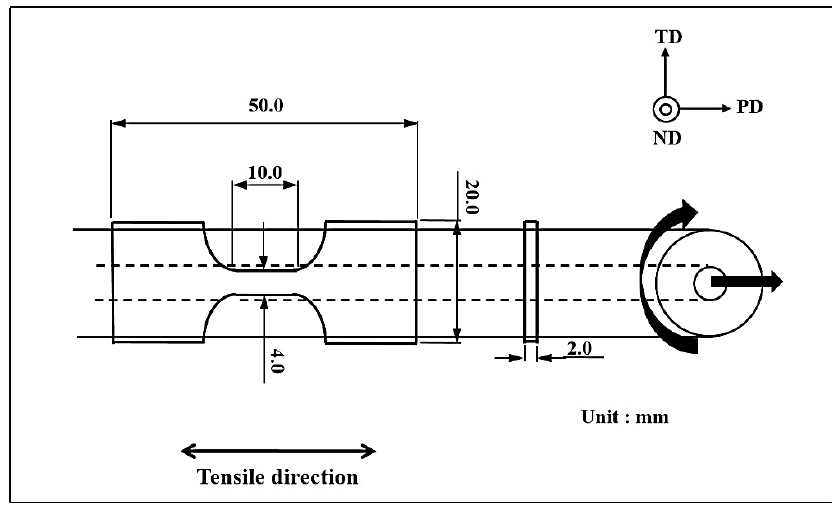
Figure 2. Schematic illustration of the tensile specimen (FSP). Processing direction: PD; normal direction: ND; transverse direction: